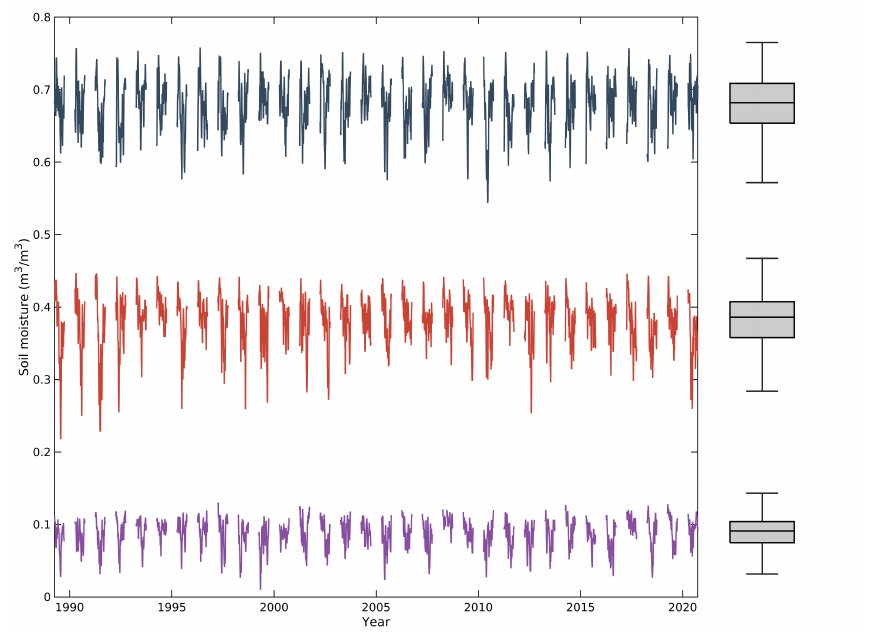
Figure 6. Evolution of SSM on the analysis points presented in Figure 1 (bottom: point A; middle: point B; top: point C). Seven-day moving averages are shown for the April–September